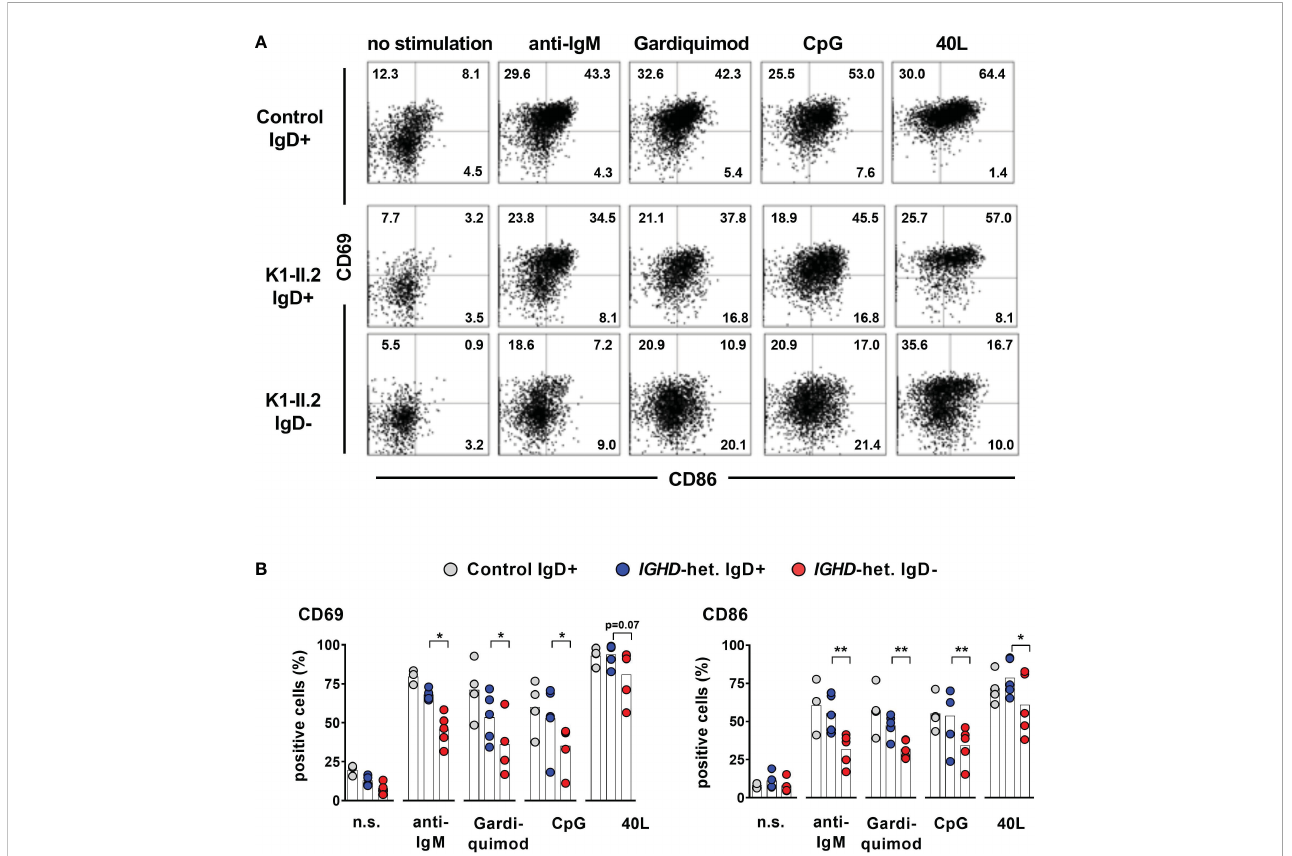
FIGURE 5 Impaired activation of IgD-negative naïve B cells after stimulation by IgM-BCR-, TLR7/9- or CD40 ligands (A) Representative dot blots showing expression of CD69 and CD86 on CD19 + CD27 - IgM + IgD + or IgD - naive B cells stimulated or not with F(ab) 2 anti-IgM, Gardiquimod (TLR7), CpG (TLR9) or CD40L for 48 hours from a control individual (upper row) or an individual carrying a heterozygous IGHD variant. (B) Compiled data from 4 control individuals as well as 5 individuals carrying different IGHD variants (paired Student`s t-test; **, p < 0.01; *, p <